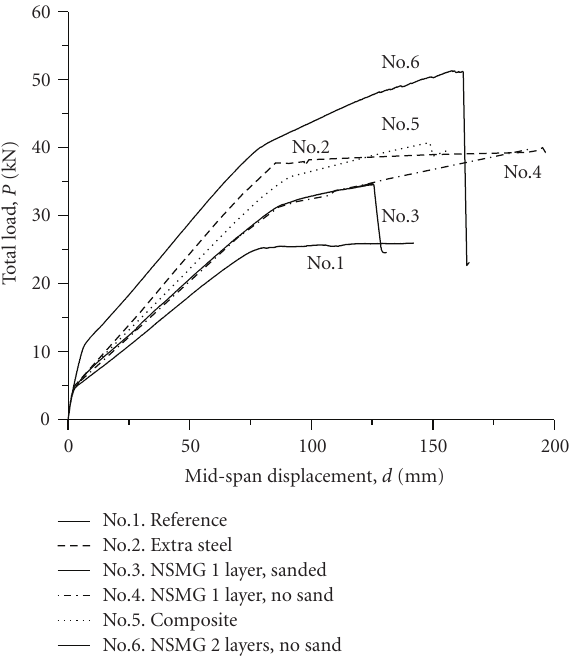
Figure 8: Load versus mid-span displacement of flexural strength- ened